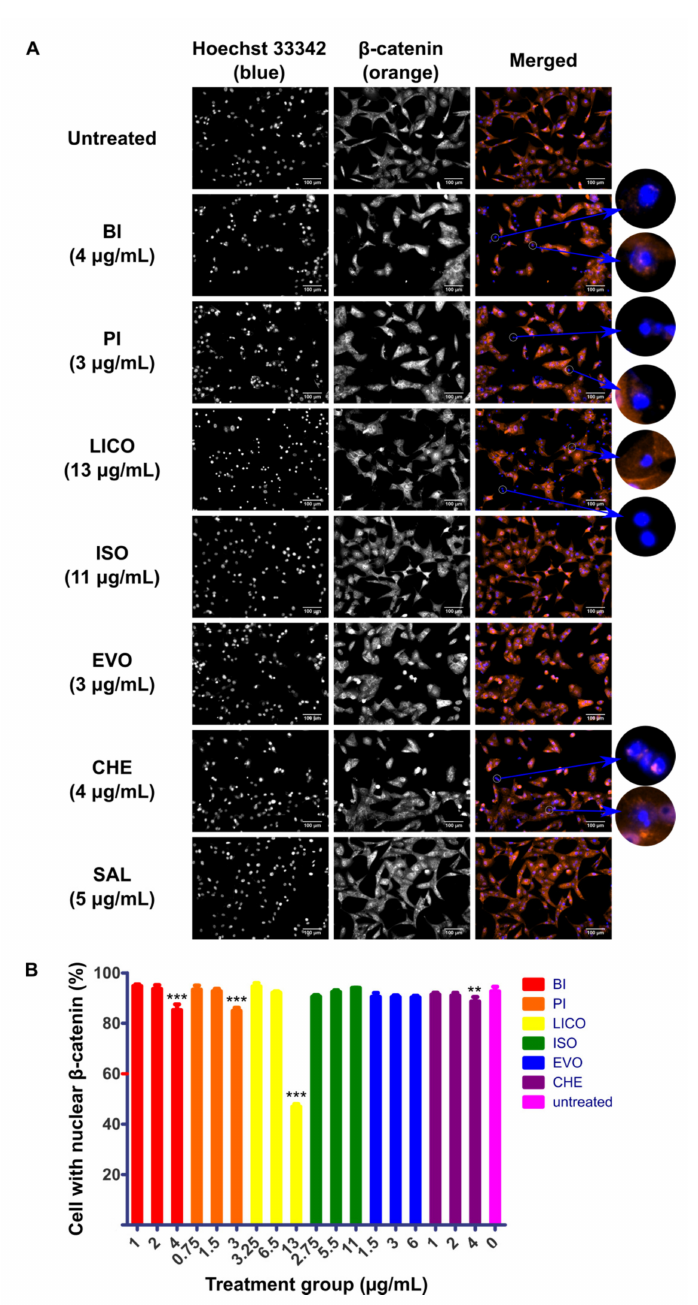
Figure 2. Immunofluorescence detecting localization behavior of β -catenin in phytochemicals-treated SK-LU-1. SK-LU-1 was pre-treated with GSK3i at 8 µ M for 24 h followed by phytochemicals treat- ments for 24 h. ( A ) Representative micrographs depicting immunofluorescence staining of β -catenin (orange) counterstained with Hoechst 33342 (blue) to indicate nuclei in phytochemicals-treated SK-LU-1. White circles highlight cells with diminished β -catenin localization in nucleus. Scale bars represent 100 µ m. ( B ) Graph representing percentage of SK-LU-1 with nuclear β -catenin calculated in response to treatment at 1 IC 50 , 1 IC 50 and IC 50 concentrations of respective phytochemicals. 2 4 The quantification data were derived from a representative immunostaining experiment. Error bars are expressed as mean ± SD from triplicate data in an independent experiment. Statistical significance is expressed as *** p < 0.001; ** p <